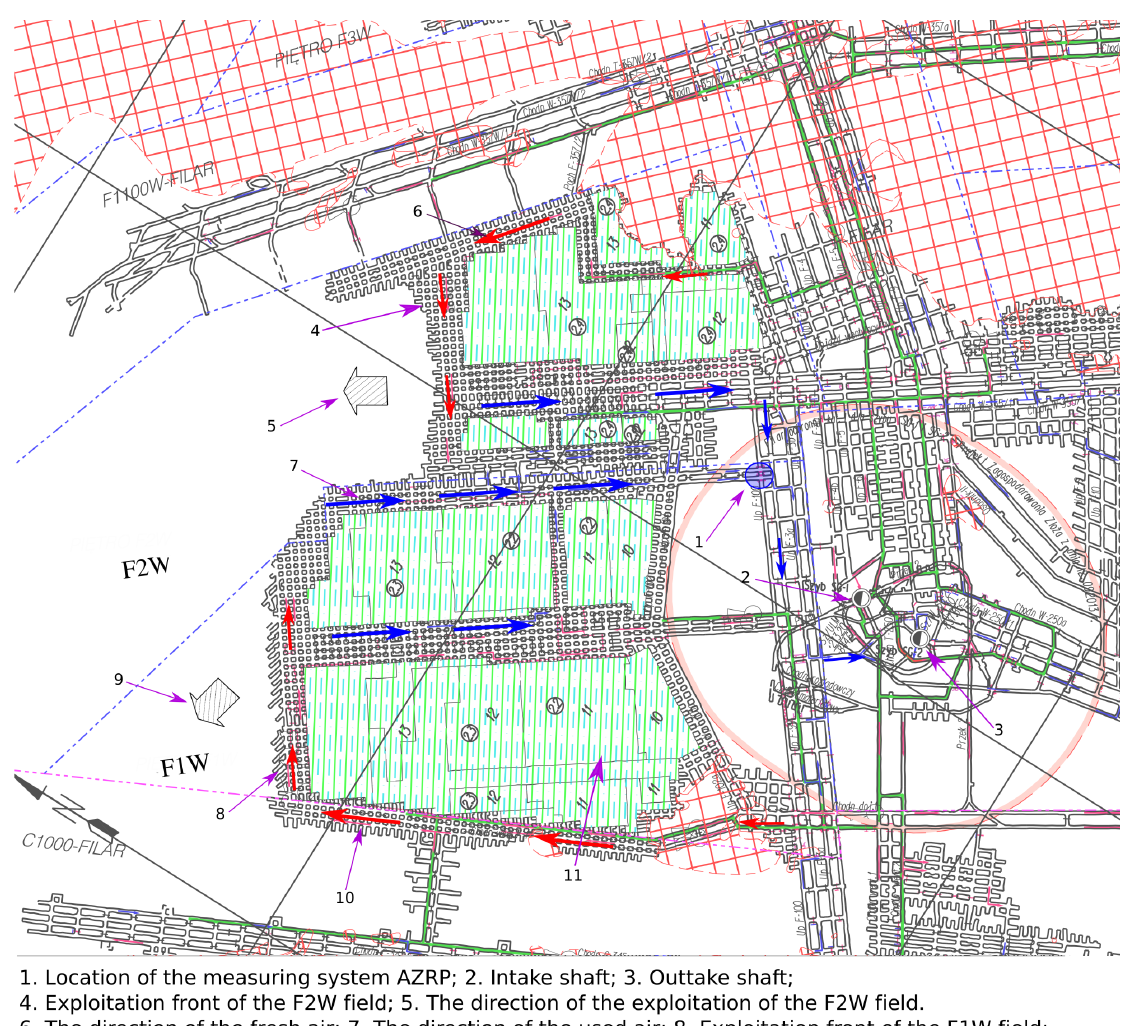
Figure 1. Map of the investigated part of the mine with fresh and used air stream flow directions and sensors